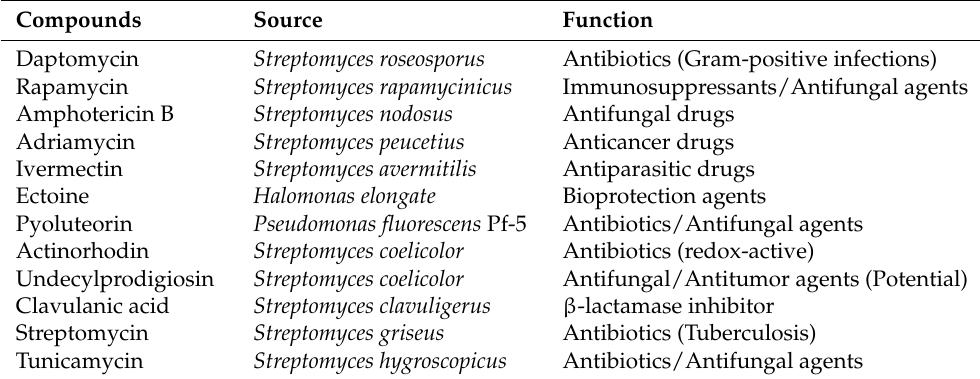
Table 1. Summary of sources and functions of twelve